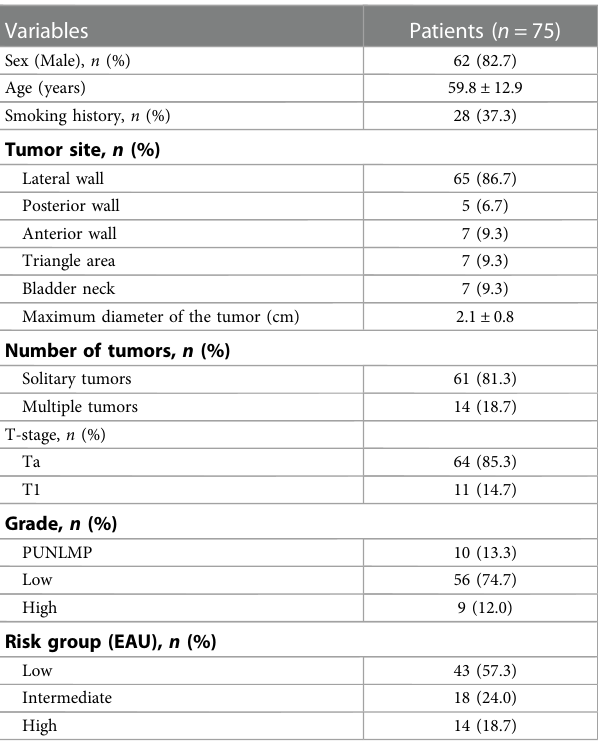
TABLE 1 Characteristics of the patients.